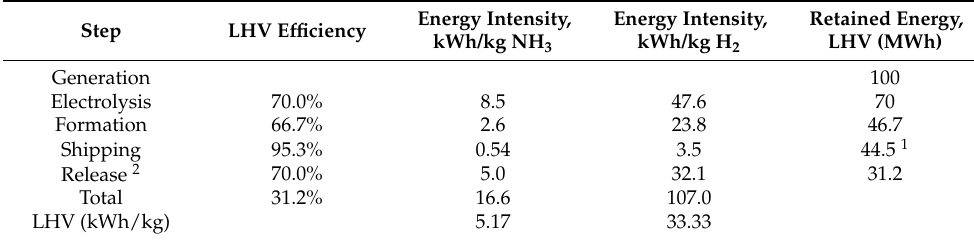
Table 5. Summary of energy efficiency for the various stages in a liquid ammonia supply